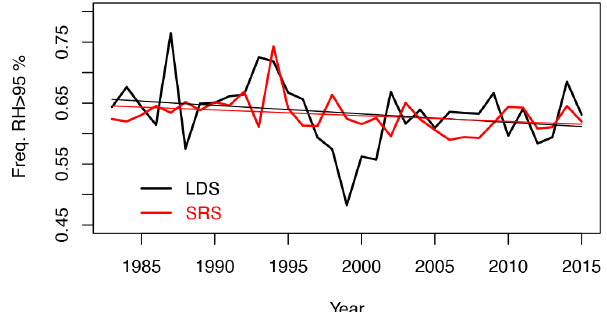
Figure 4. Time series of relative humidity. Time series from 1983– 2015 and simple linear-regression lines show the temporal evolution of the frequency of relative humidity exceeding 95% averaged from 925–975hPa. Data are shown for the LDS (black) and the SRS (red) and are spatially averaged over the entire study region (see Fig.